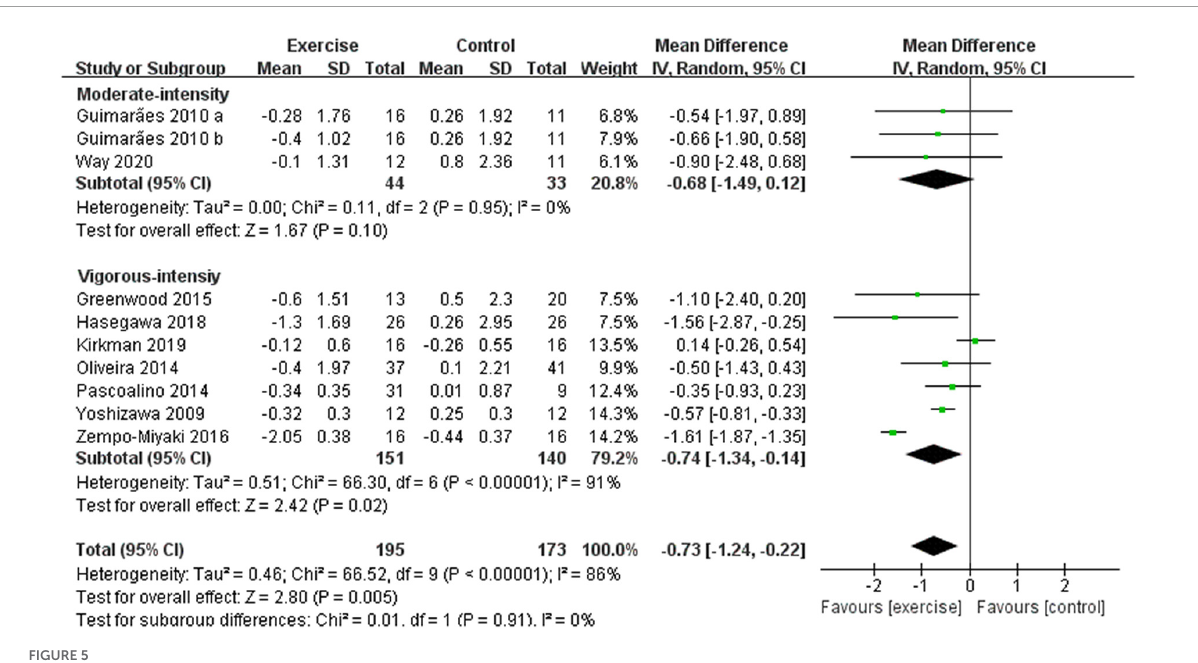
FIGURE5 Meta-analysis results of the effect of different intensities of aerobic exercise on the PWV of middle-aged and elderly people. The pooled estimates were obtained from random effects analysis. Diamonds indicate the size of the effect of each study summarized as WMD. The size of the shaded square is proportional to the percentage weight of each study. Horizontal lines represent the 95% CI and the vertical dashed line represents the overall effect.